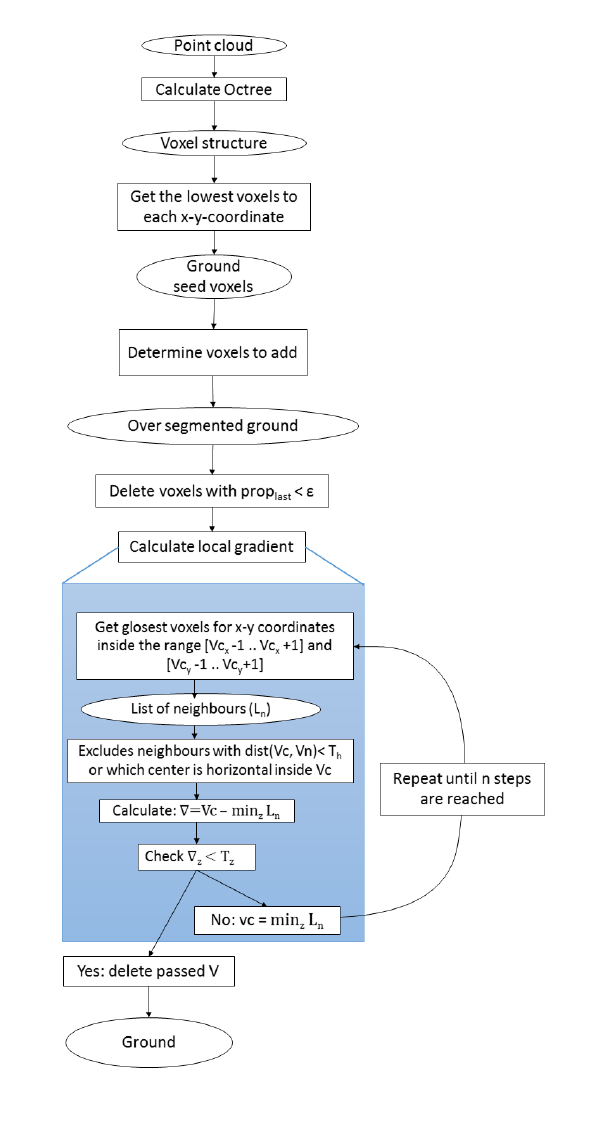
Figure 1. Schematic workflow of the ground detection. Recangles show processing steps and ellipses the output of the processing step. The gradint calculation is divided into its sub processing steps which are shown in the blue box.